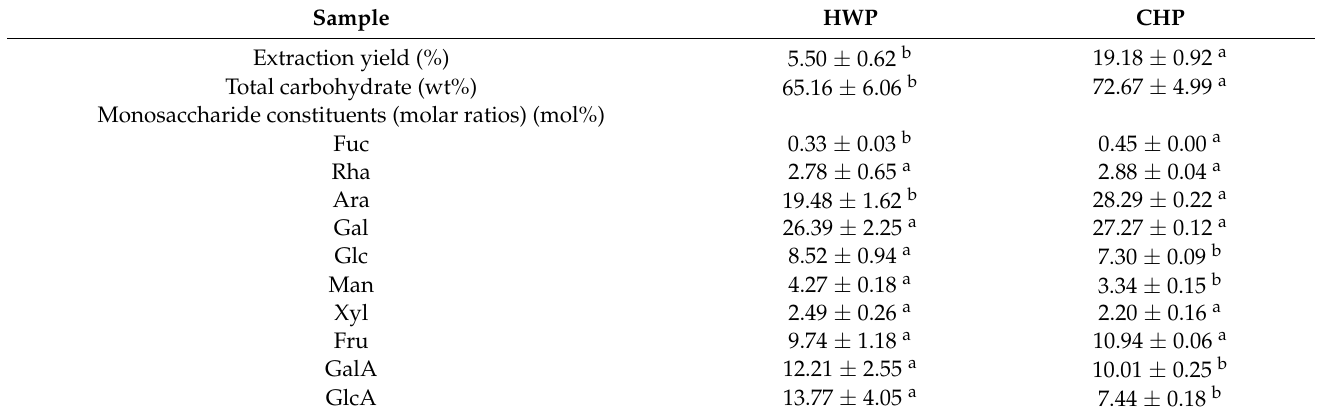
Table 3. Extraction yield, total carbohydrate, and monosaccharide composition of HWP and CHP. Sample Extraction yield